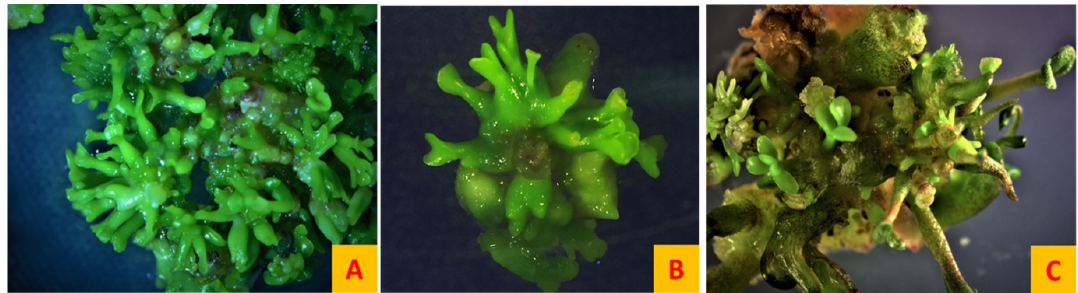
Figure 4. Somatic embryogenesis on the B5h-B5 system. ( A ) Inoculation of the leaf layer explant on the B5h medium, ( B ) complete callus formation after 18 d on the B5h medium, ( C ) induction of somatic embryos after seven days on the B5 medium, ( D ) synchronous culture of mature somatic embryos after 21 days on the B5 medium and ( E ) mature cotyledonary stage embryo ready to be harvested after 21 days on the embryo maturation medium. All images were at 8× magnification except Image E (24×).